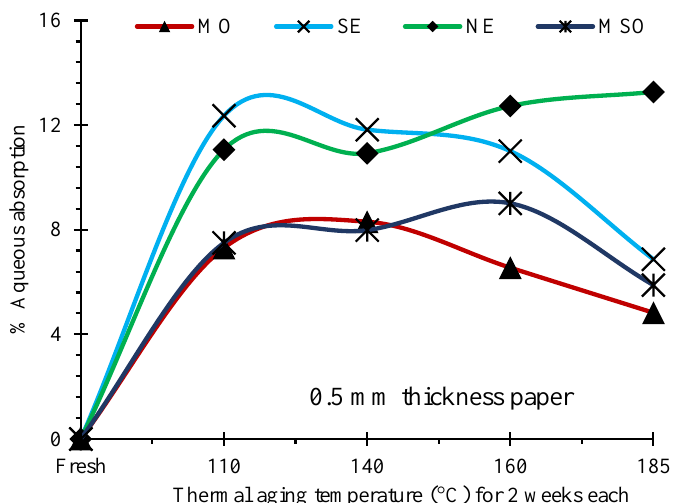
Figure 9. Wetting characteristics of 0.5 mm thickness papers with thermal stressing in various insulating oils.